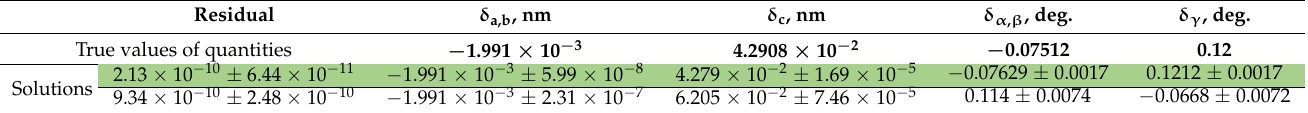
Table 1. Comparison of the true values of lattice distortions of a cubic lattice with the numerical solution found for two types of calculations δ a = δ b (cid:54) = δ c , δ α = δ β (cid:54) = δ γ . The sign of ± indicates the standard deviation from the average value of the 200 solutions with the minimal residual function